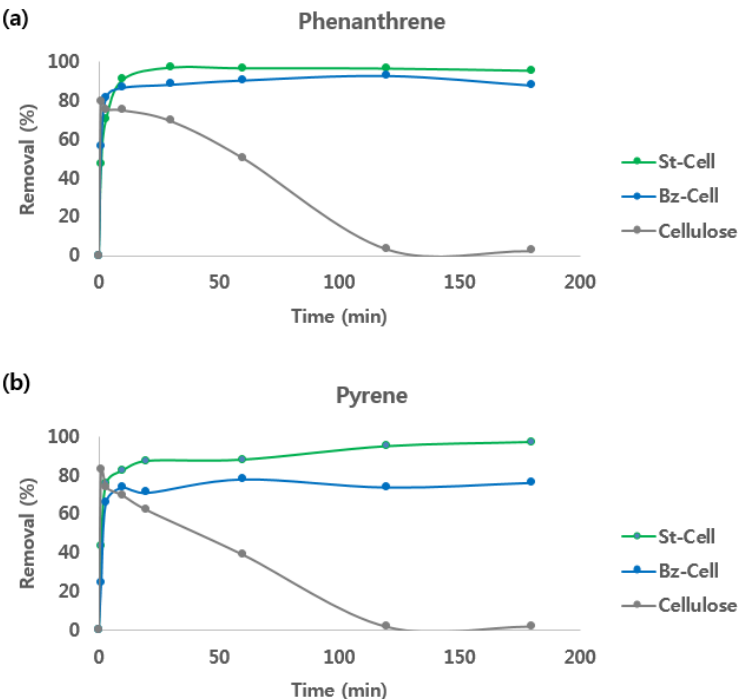
Figure 8. The time-dependent removal (%) of phenanthrene ( a ) and pyrene ( b ) by the Bz–Cell and St–Cell, compared with cellulose.